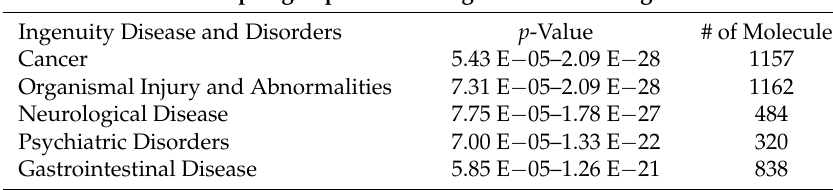
Table 1. Top 5 Ingenuity®Pathway Analysis (IPA) disease and disorder categories for each treatment group and sex compared to sex-matched air